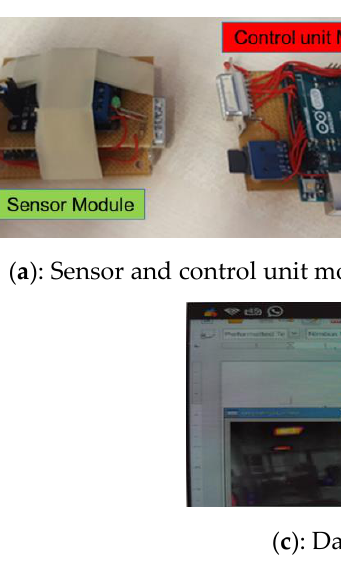
Figure 13. Prototype of modular IoT DAQ.